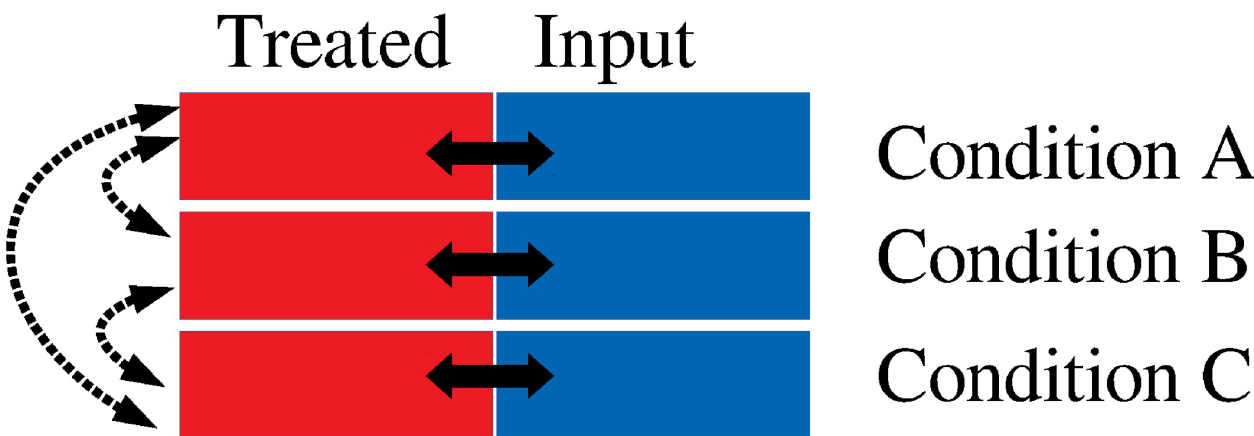
Fig 9. Schematics that illustrates the difficulty of differential binding analysis. In contrast to differential expression analysis that requires only inter conditions comparisons (displayed by broken bidirectional arrows), differential binding analysis requires additional intra conditions comparisons between treated and input experiment (displayed by bidirectional solid arrows). There are no pipelines that aim to identify differential binding considering simultaneously more than two conditions.